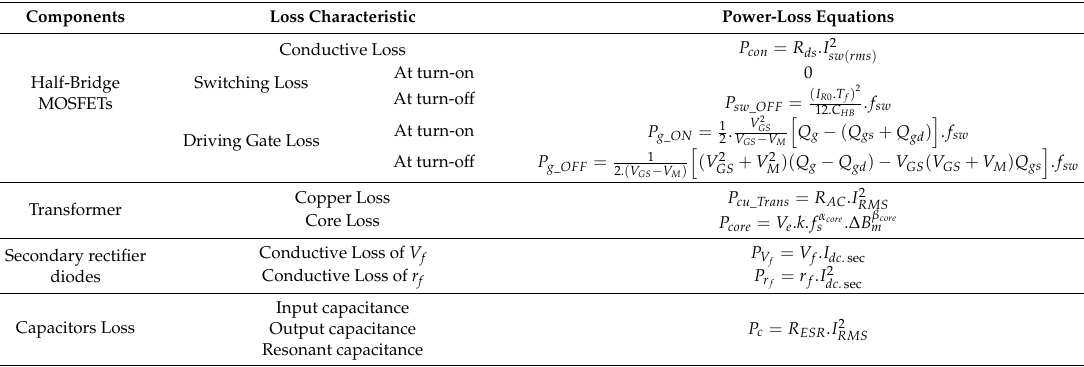
Table 2. Power-loss equations of LLC resonant half-bridge converter